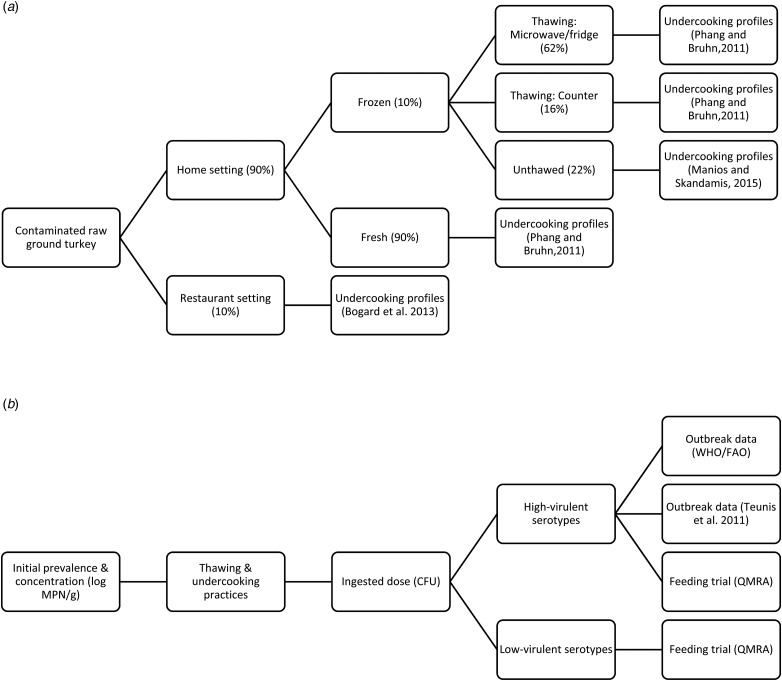
Risk assessment model framework. (a) Thawing and cooking scenarios. (b) Dose–response approach.